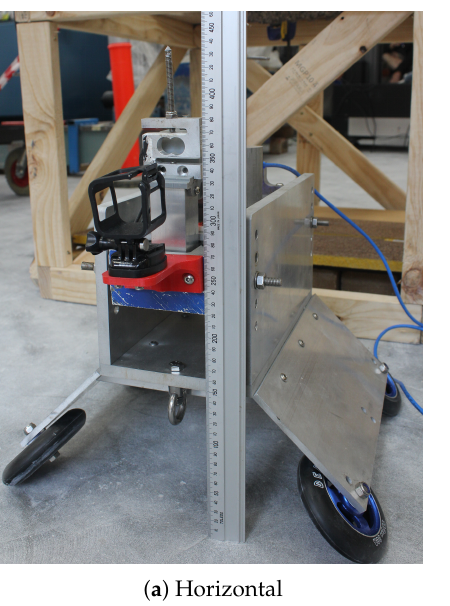
Figure 7. Penetrometer mounts for different pipe orientations.